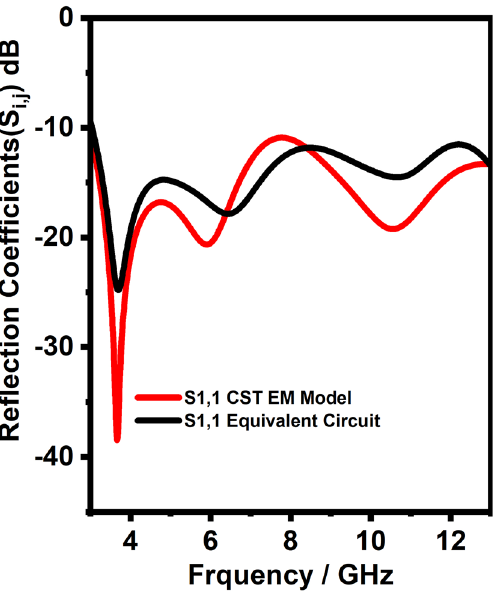
Figure 6. S-Parameter comparison between CST EM model and equivalent circuit model for UWB antenna.